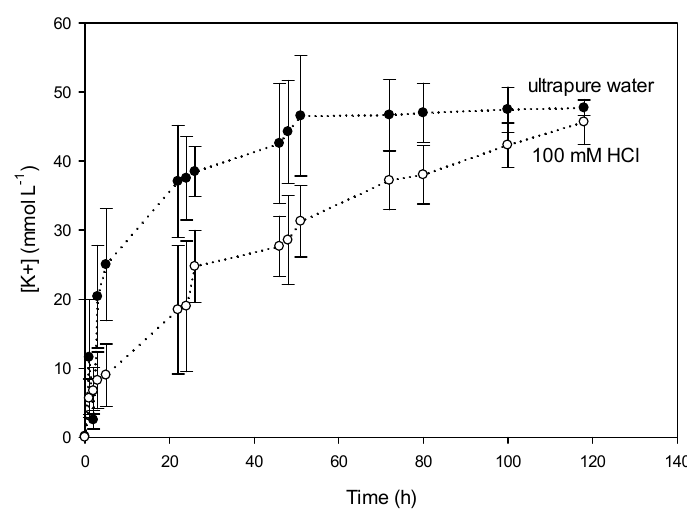
Figure 5. Evolution using PIM-8 of [K + ] in the receiving compartment in two different receiving phases: ultrapure water and 100 mM HCl.